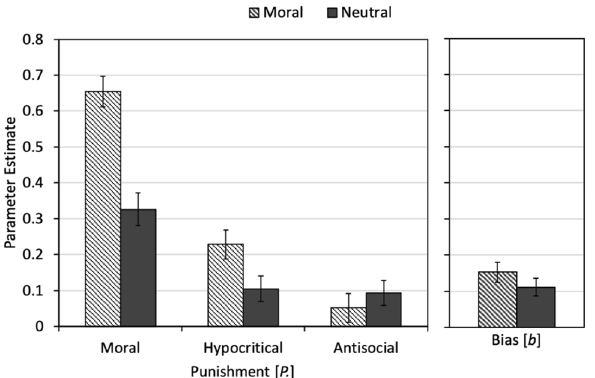
Figure 5. Estimates of the parameters reflecting moral punishment ( P Moral ), hypocritical punishment ( P Hypocritical ) and antisocial punishment ( P Antisocial ) are displayed as a function of framing (moral, neutral) in the left panel. The estimate of the punishment bias ( b ) parameter is shown in the right panel. The error bars represent standard